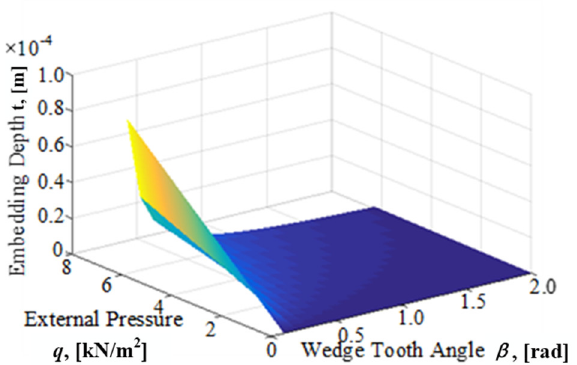
Figure 11. The Relationship between Wedge Insertion Depth and External Load and Wedge Tooth Angle.